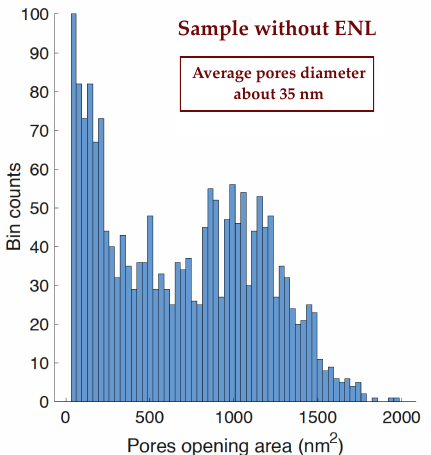
Figure 8. Distribution of the pore opening size for a sample without ENL before the formation.